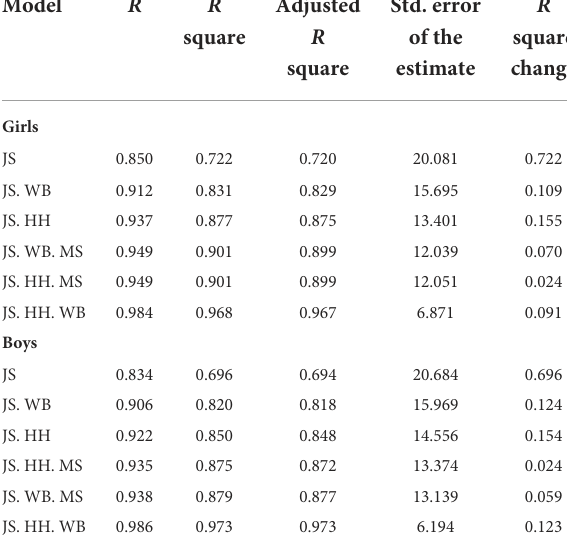
TABLE 3 Data from stepwise linear regression declared among 7-year aged subject of both sexes.